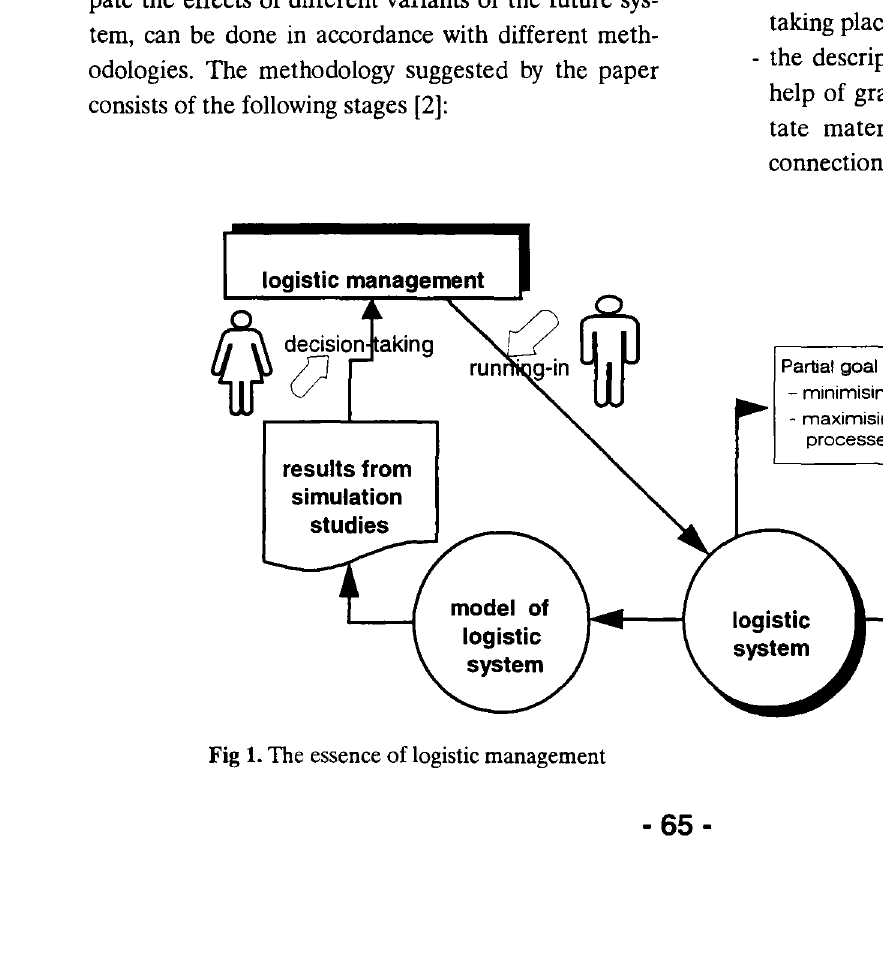
Fig 1. The essence of logistic